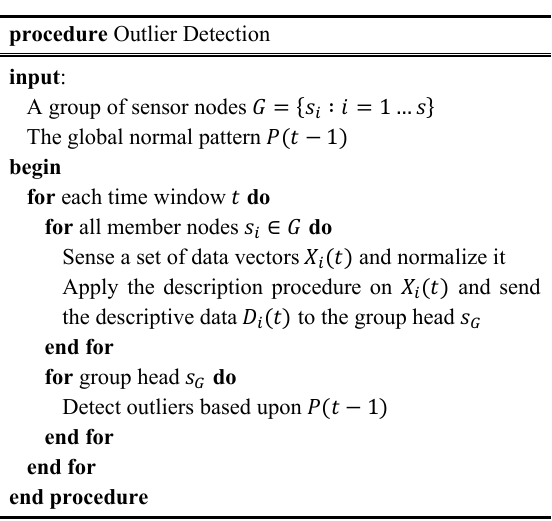
Figure 5. The outlier detection